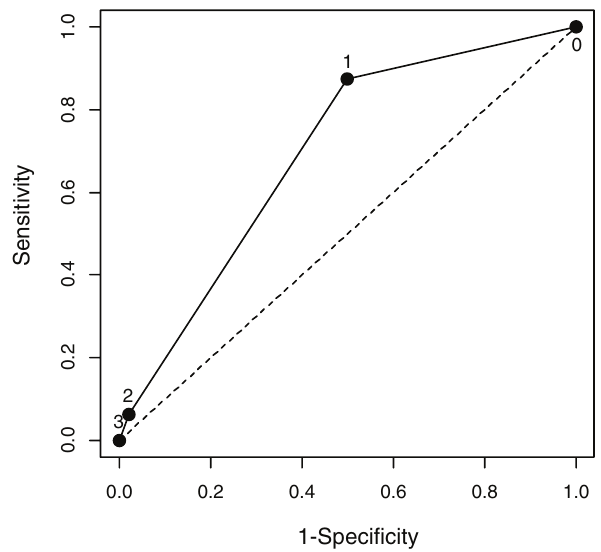
Figure 1. A receiver-operating-characteristic (ROC) curve evaluating the sensitivity and specificity of preoperative independent risk factors for LMA difficulty. Two independent predictors for LMA difficulty were identified using logistic regression: Female and NeckCirc of 44 or greater. The area under the curve was 0.69. The area under the curve was calculated to evaluate the resulting model’s predictive value. The adjusted odds ratios and their 95% confidence interval were calculated. Continuous variables were included after the dichotomization and the best cut-off was determined by maximizing the sum of sensitivity and specificity using the ROC curve. Analyses were conducted using SAS 9.3 (SAS Institute, Cary, NC,